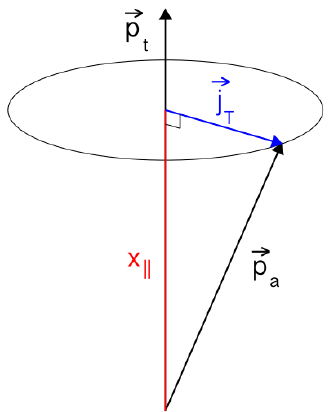
Figure 1 . Illustration of ~j T and x . The jet fragmentation transverse momentum, ~j T , is de(cid:12)ned as k the transverse momentum component of the associated particle momentum, ~p a , with respect to the trigger particle momentum, ~p t . The fragmentation variable x is the projection of ~p a to ~p t divided k by p t